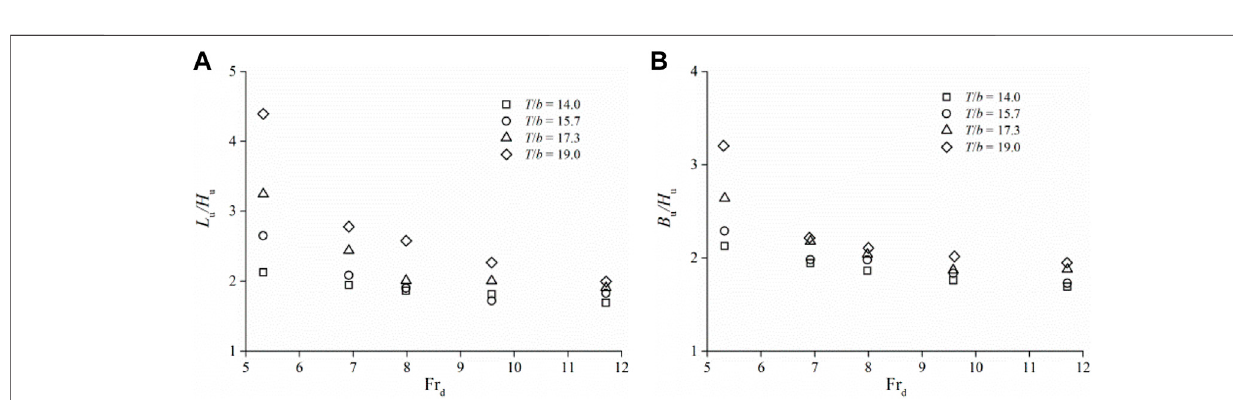
FIGURE 7 | Effects of jet impact on three-dimensional scour scales: (A) T / b = 17.3; (B) Fr d = 5.3.